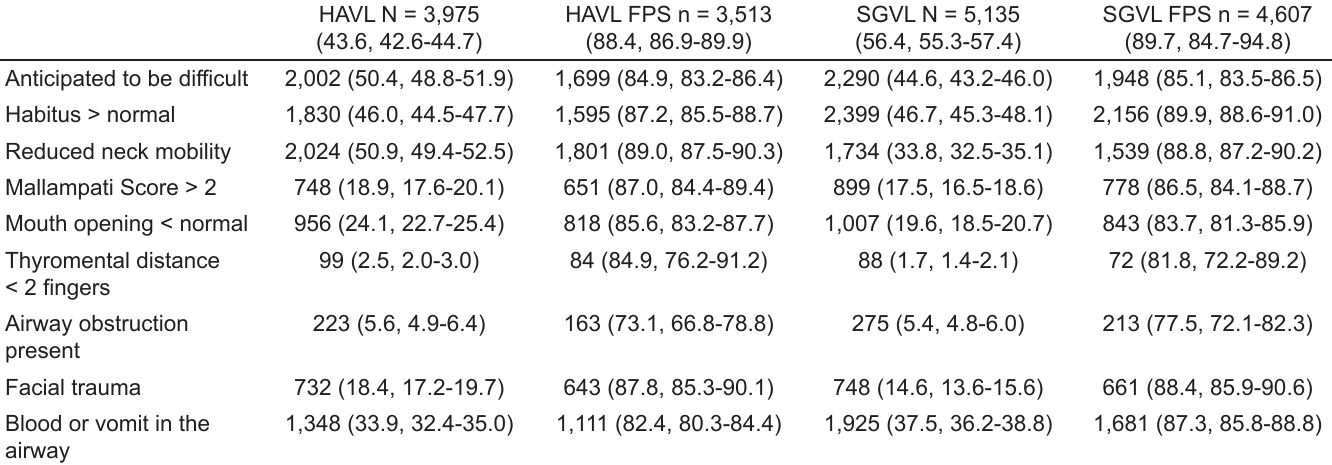
Table 3. Comparative first-pass success rates of hyperangulated video laryngoscopy (VL) and standard geometry VL for each difficult airway